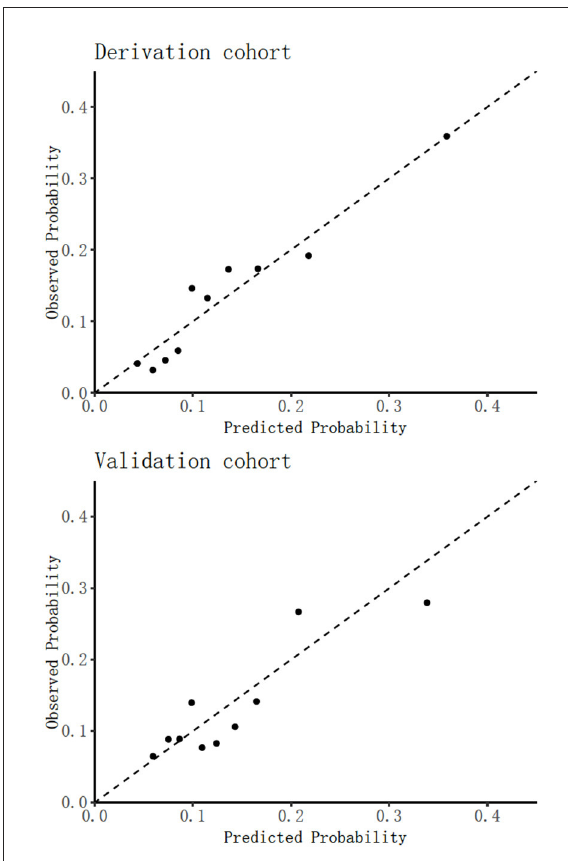
FIGURE2 Assessing calibration in derivation cohort (top) and validation cohort (bottom) .